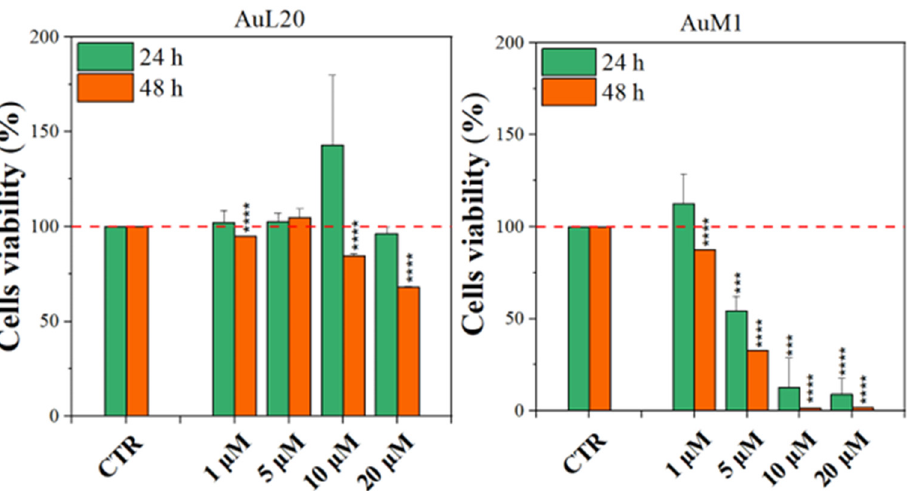
Figure 4. Cell viability of MeWo cells treated with different concentrations of each metallic complex for 24 and 48 h by the MTT assay. The experiments were analyzed by two-tailed Student’s t -test, *** p < 0.001 and **** p ≤ 0.0001.